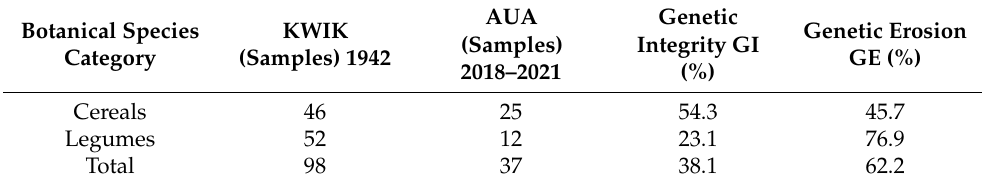
Table 9. Estimation of the genetic erosion of landraces of Arcadia comparing the collections of KWIK in 1942 and AUA in